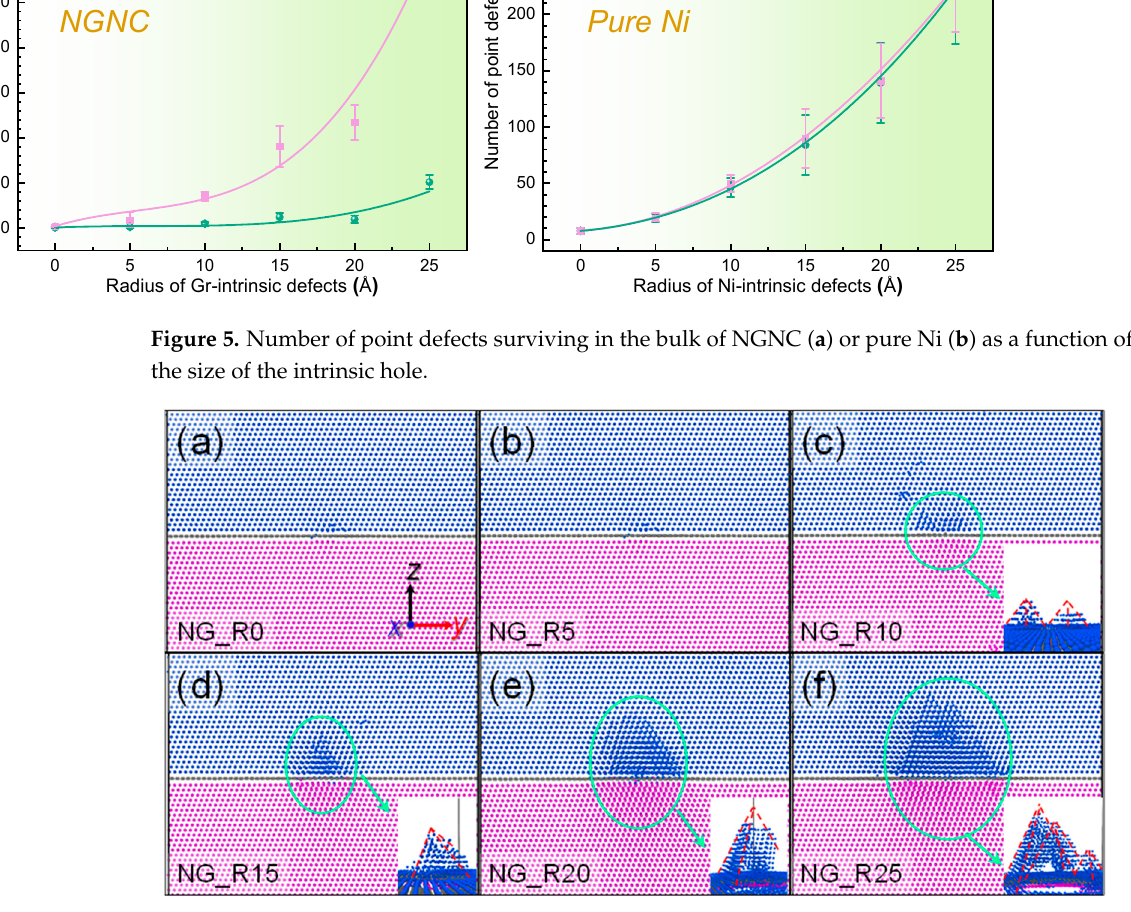
Figure 6. Snapshots of the six NGNC models extracted from the ending moment of cascades. ( a ) NG_R0. ( b ) NG_R5. ( c ) NG_R10. ( d ) NG_R15. ( e ) NG_R20. ( f ) NG_R25. SFT-like structures are labeled.